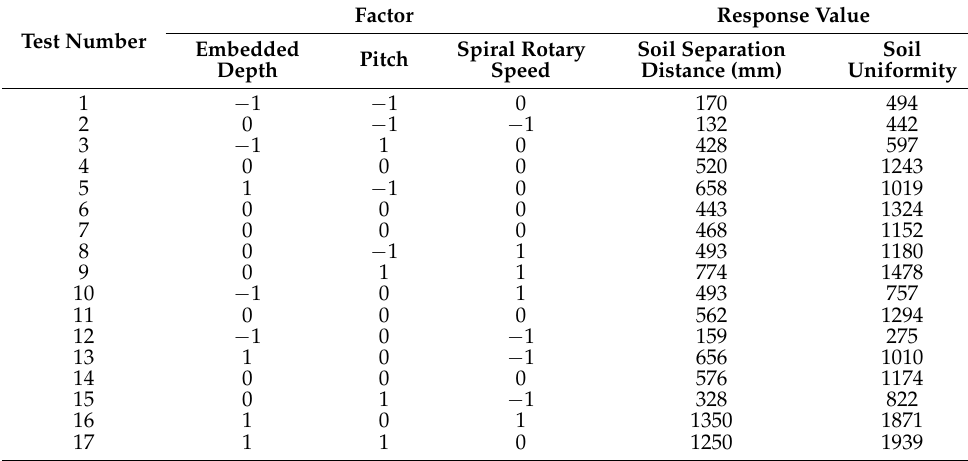
Table 4. Response surface analysis test design and results.